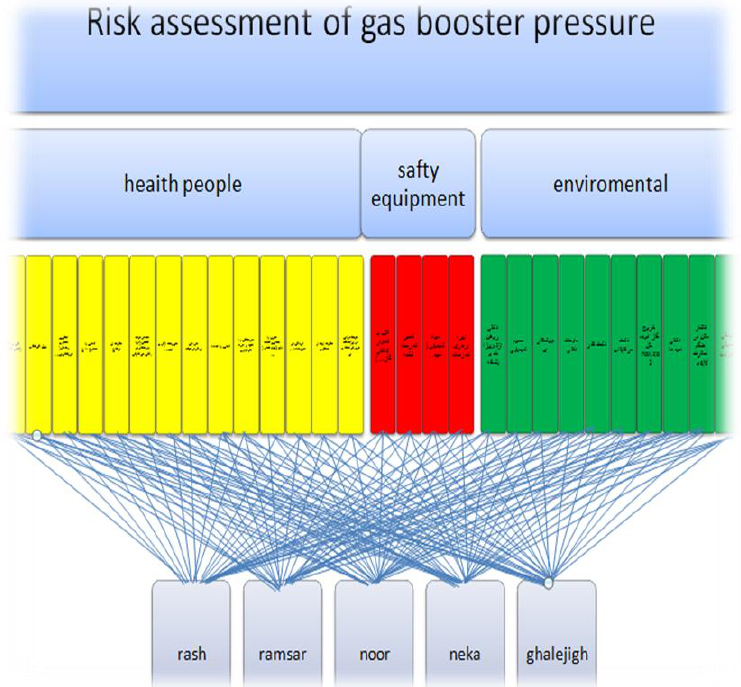
Figure 5. Hierarchical tree selection decision